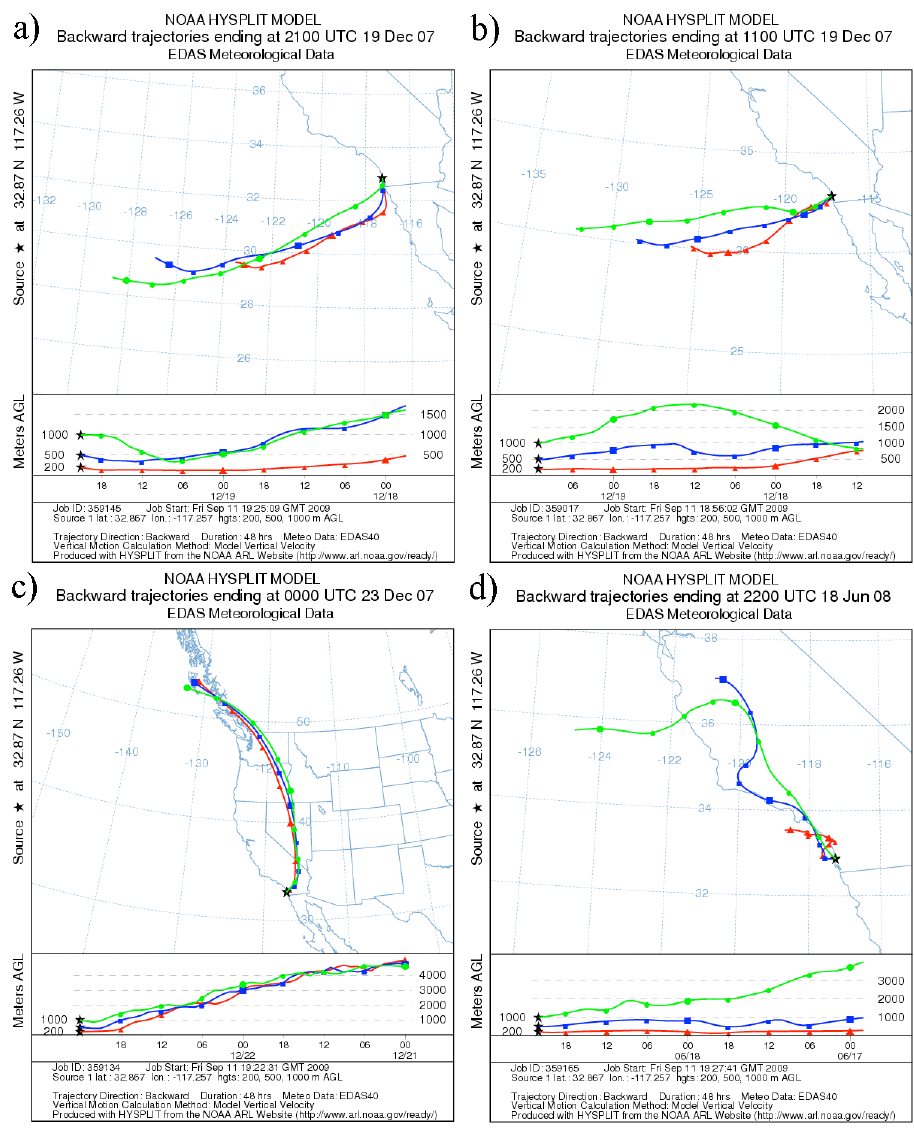
Fig. 1. Representative 48-h HYSPLIT air mass back trajectories for each filter set (A–D) . Dots correspond to 6h increments and lines correspond to trajectories taken at 1000m (green line), 500m (blue line), and 200m (red line).